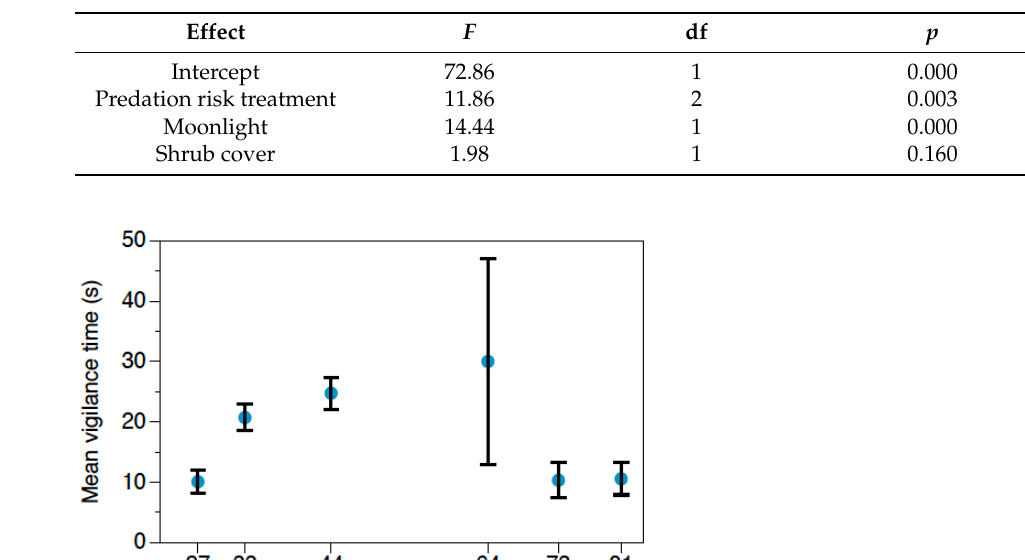
Table 8. Results of the GLM analyzing the effect of experimental and environmental factors on O. longicaudatus vigilance behavior.